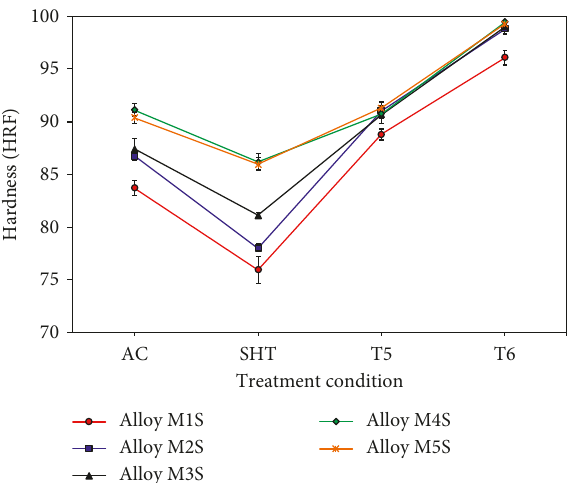
Figure 10: Variation in total impact energy value as a function of heat-treatment conditions for the alloys